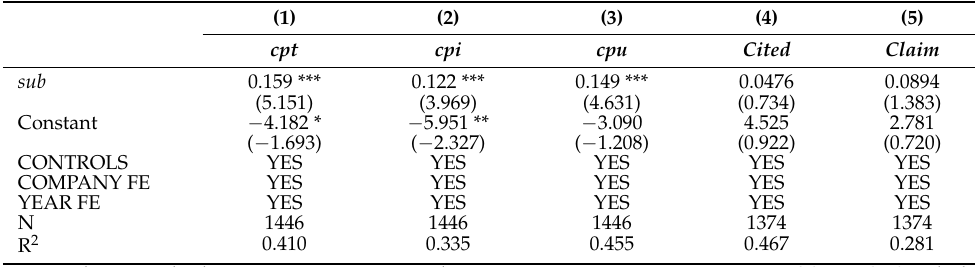
Table 6. Robustness test: Replace the dependent